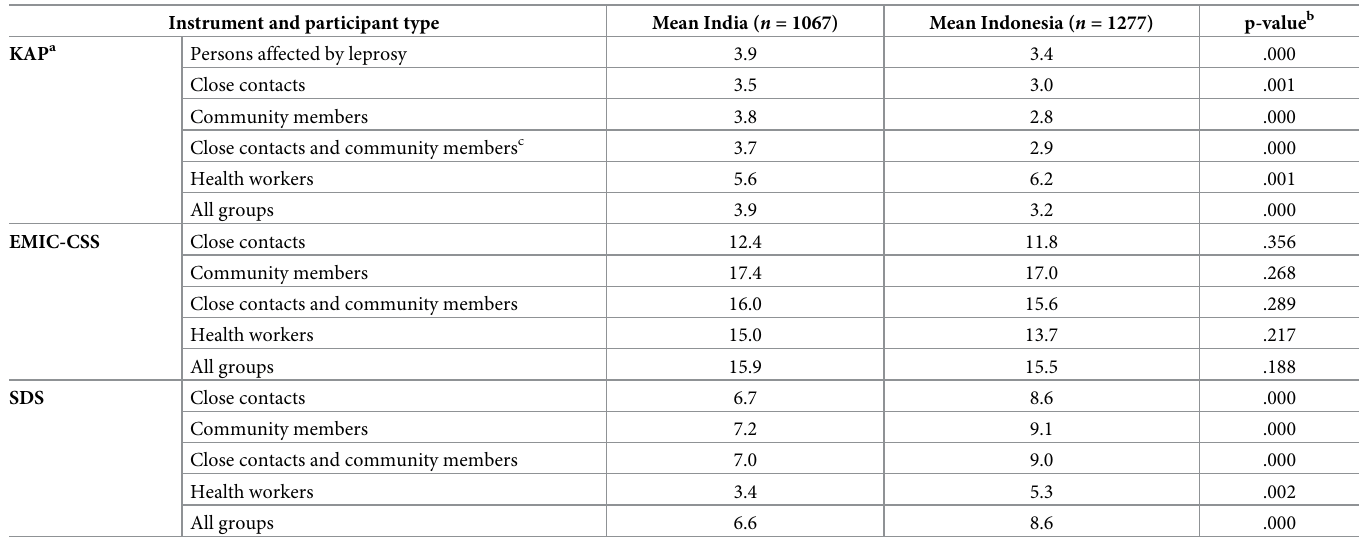
Table 2. Differences in total scores on the KAP (range 0–8), EMIC-CSS (range 0–30) and SDS (range 0–21) per participant group, per country. Instrument and participant